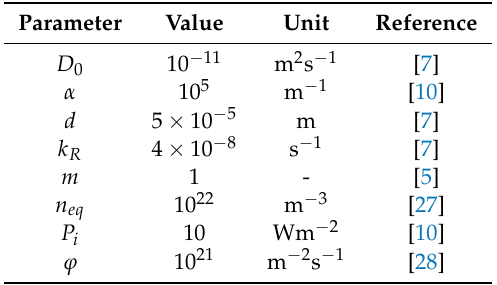
Table 1. Parameter values for the Dye-Sensitized Solar Cell (DSSC) model. Parameter